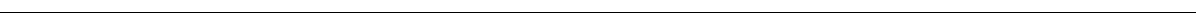
Fig. 3 Carvedilol promotes G α i recruitment and activation in β 1 AR stable cells, but not in β 2 AR stable cells. HEK293 cells stably expressing FLAG-tagged β β μ M carvedilol or 10 μ M isoproterenol for 5 min. a In proximity ligation assay (PLA), cells were immuno-stained 1 ARs or 2 ARs were stimulated with 10 with G α i antibody raised in mouse and β 1 AR (or β 2 AR) antibody raised in rabbit. The red PLA signal represents the protein interactions of G α i and β 1 AR (or β α β β = 20 μ m. b β 2 AR). The area in yellow squares are enlarged for better view. Carvedilol promoted G i recruitment to 1 ARs, but not to 2 ARs. Scale bar 1 AR stable cells were pretreated with vehicle or 10 μ M propranolol for 30 min. The β AR antagonist propranolol blocked the carvedilol response, suggesting that β – G α β = 20 μ m. c The effect of carvedilol and 1 AR i coupling is induced by the binding of carvedilol to the 1 AR orthosteric binding pocket. Scale bar isoproterenol on G α i recruitment was con fi rmed with co-immunoprecipitation assays. FLAG-tagged β 1 ARs or β 2 ARs were immunoprecipitated with anti- FLAG M2 beads, and G α i3 was detected with its speci fi c antibody by western blot. d Carvedilol speci fi cally activated G α i in β 1 AR stable cells. Cells were transfected with G α i2 . 48 h after transfection, cells were treated with 10 μ M carvedilol for 5 min or 30 min, or 10 μ M isoproterenol for 5 min. Activated G α i was immunoprecipitated with an antibody speci fi cally recognizing the active form of G α i , and immunoblotted with an G α i antibody. In the middle lane marked as actG α i , cells were transfected with constitutively active G α i2 , serving as positive control. Carvedilol stimulation activated G α i in β 1 AR stable cells, but not in β 2 AR stable cells. Data represent the mean ± SEM for n independent experiments as marked on the fi gure. Statistical signi fi cance vs. unstimulated cells (NS) was assessed using one-way ANOVA with Bonferroni